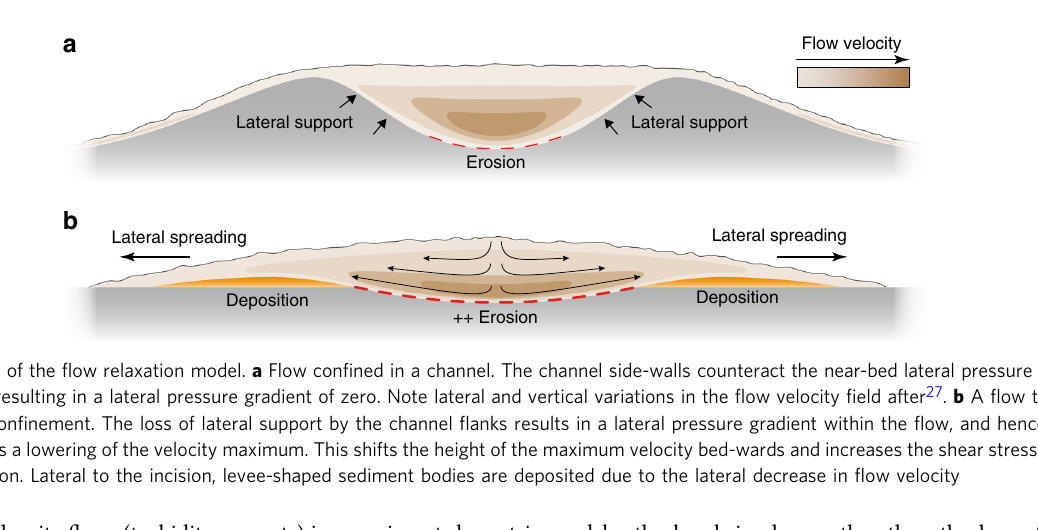
Fig. 4 Flow-dynamic parameters captured by the velocity probes. a Time-averaged velocity pro fi les for the turbidity current in the experiment with loss of con fi nement. b Time-averaged velocity pro fi les for the turbidity current in the reference experiment (see Figs. 2 and 3 for probe locations). c Depth- averaged velocity. The turbidity current downstream of the loss of con fi nement was slower than the turbidity current in the reference experiment. d Flow thickness. After leaving the con fi nement the calculated turbidity current thickness decreased. e Shear velocity. Shear velocity downstream of the loss of con fi nement was increased in comparison with the reference experiment. See Methods for details on average calculations